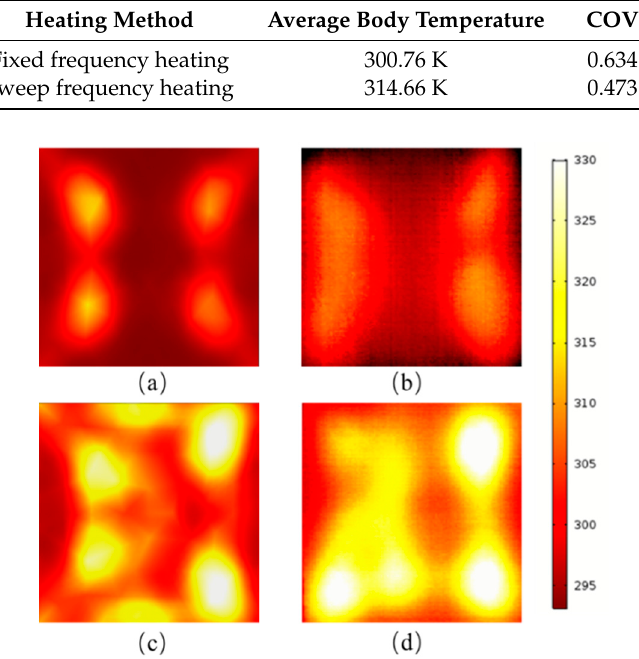
Figure 10. Experiment and simulation results of pear surface temperature distribution (unit: K): ( a ) Simulated heating results of the fixed frequency heating; ( b ) experimental heating results of the fixed frequency heating; ( c ) simulated heating results of the sweep frequency heating; and ( d ) experimental heating results of the sweep frequency heating.